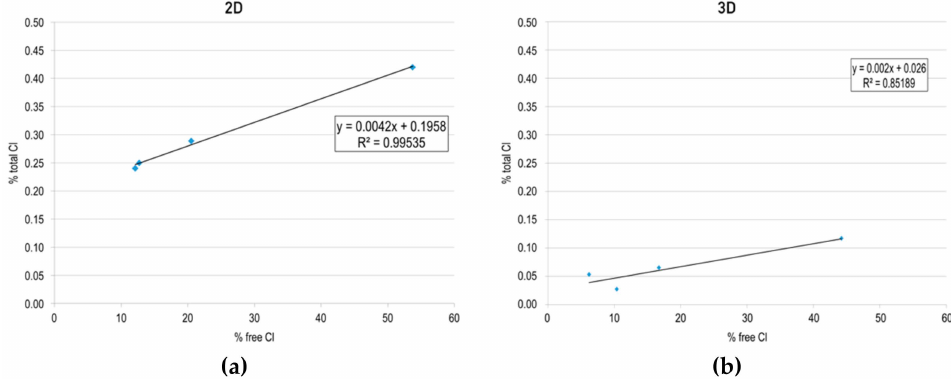
Figure 12. Calculated m value versus the apparent di ff usion coe ffi cient obtained for specimens submerged in an aggressive medium at early ages: ( a ) after two days and ( b ) three days of